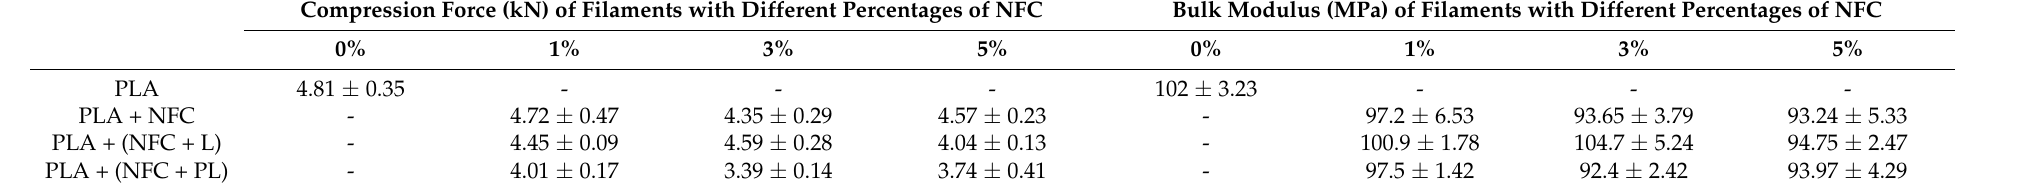
Table 5. Compression force and bulk modulus of filaments; mean value ± SD.